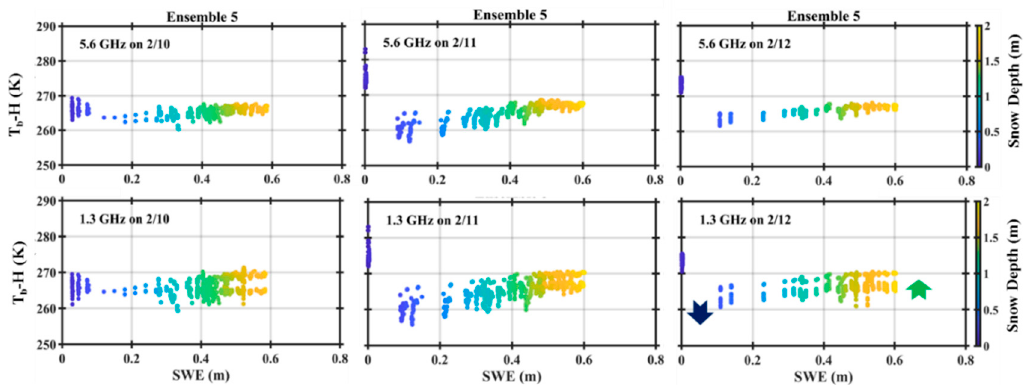
Figure 14. Diurnal cycle of brightness temperature Tb-H at 5.6 GHz ( top row ) and 1.3 GHz ( bottom row ) for all Ensemble 5 members, thus capturing the snowpack's spatial variability across the Grand Mesa during the warm weather period 2/10–2/23 from left to right. Note snowpack disappearance for some ensemble members (SWE = 0) on 2/11 (e.g., Figure 11) and 2/12 due to melting. The high ambiguity (spatial variance) introduced by the local meteorology is apparent with multiple SWE values for each Tb at 5.6 GHz, particularly for intermediate and deep snow and during the daytime. The green arrow indicates the direction of Tb increase during nighttime cooling and refreezing of the snowpack; the dark blue arrow indicates Tb decrease during daytime warming with substantial surficial